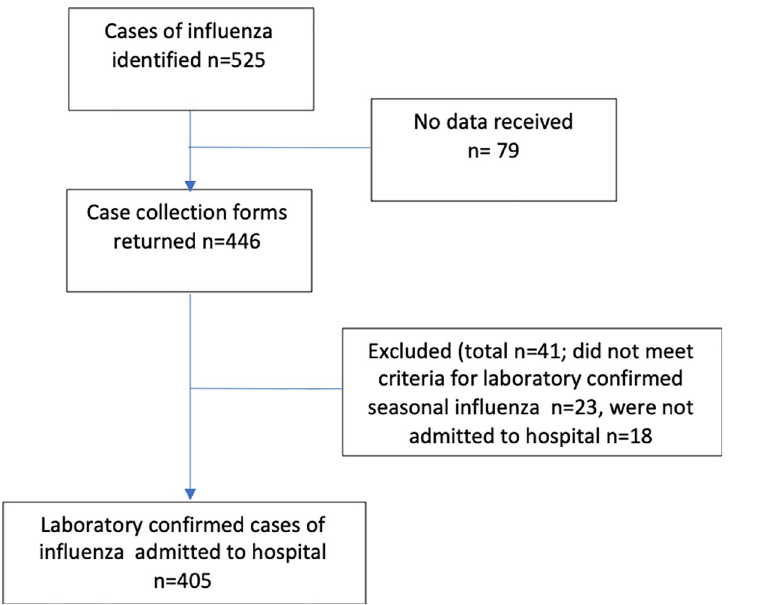
Fig 1. Identification of case women eligible for inclusion in the